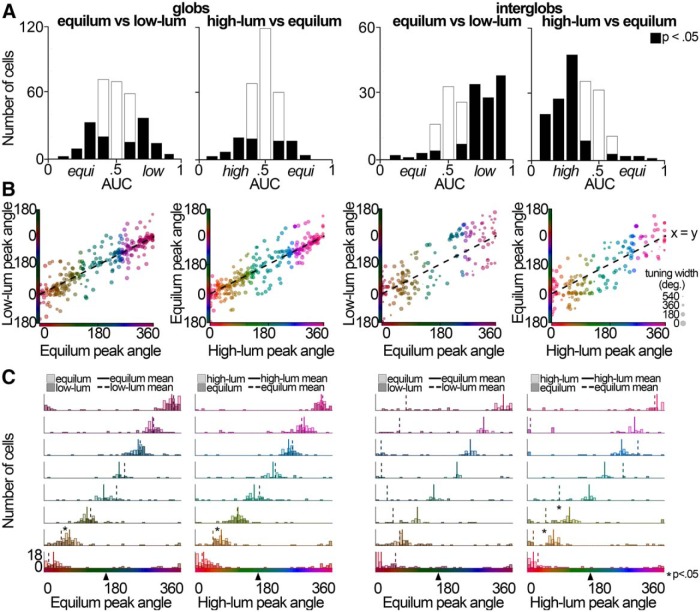
Effect of stimulus luminance on tuning. A, Luminance sensitivity of cells in the glob (left) and interglob (right) populations assessed by ROC analysis. Interglob cells exhibit a preference for low-luminance or high-luminance stimuli over equiluminant stimuli. The histograms show AUCs for the ROC for each cell, for two luminance discrimination problems. An AUC <0.5 indicates a neuron preferred the first luminance in the pair; an AUC >0.5 indicates a preference for the second. Black bars indicate cells that significantly preferred one of the two luminance categories (p < 0.05, permutation test). The interglob population had significantly more cells whose AUCs were significantly different than chance than did the glob population, for both luminance discriminations (equiluminant/low-luminance: p = 0.00002, Fisher’s exact test, two-tailed; high-luminance/equiluminant: p = 2.6 × 10−13). B, Luminance-invariant color tuning assessment in globs (left) and interglobs (right). For each cell, the peak angle within the low-luminance set is plotted against the peak angle within the equiluminant set (first and third columns), and the peak angle within the equiluminant set is plotted against the peak angle within the high-luminance set (second and fourth columns). The marker color indicates the hue to which the cell maximally responded for the x-axis stimulus set. The marker size increases with the cell's tuning narrowness. Because color space is circular, stimuli are rotated to appear at the y-axis point as close to the x = y line as possible. For example, if a cell had its peak at 10 CIELUV degrees for the equiluminant set and 355° for the low-luminance set, it would be plotted at (10, −5) rather than (10, 355). C, Peak shifting histograms. Each cell was placed into one of eight bins based on the angle to which it maximally responded within a luminance level. Lighter bars show the peak tuning of the cells in each bin at the lighter of the two luminance values shown (equiluminant for the first and third columns, high-luminance for the second and fourth columns). Darker bars show the peak tuning of the same cells, at the darker of the two luminance values shown (low-luminance for the first and third columns, equiluminant for the second and fourth columns). The solid line shows the mean tuning angle for the higher of the two luminance values shown, and the dashed line shows the mean tuning angle of the cells at the darker of the two luminance values shown. Arrowhead designates the peak rod response hue angle.